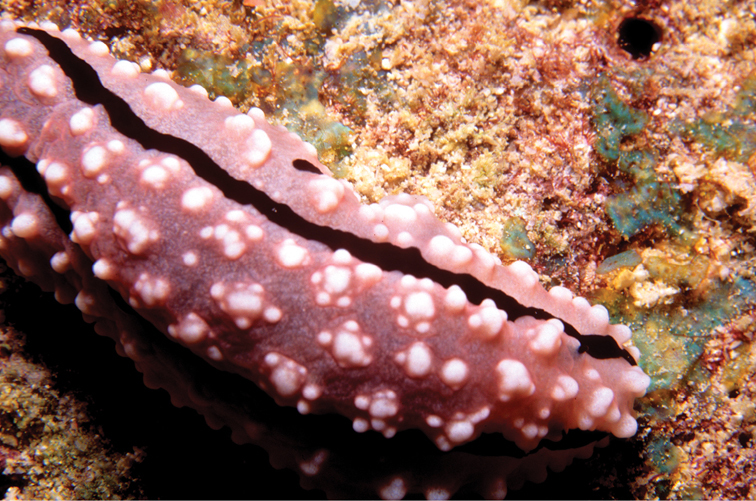
Phyllidiella rudmani, 35 mm, Maldives, photo: N Yonow (spcm in Yonow 1996).